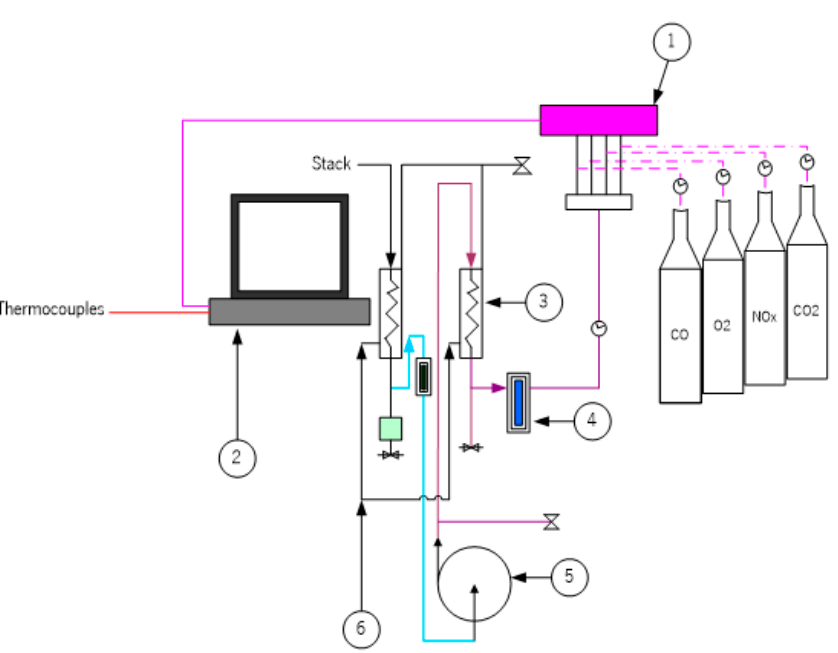
Figure 4. Flue gas analyser scheme: 1. Gas analyser; 2. Data acquisition system; 3. Cooling loop; 4. Filter; 5. Vacuum pump; 6. Water inlet.